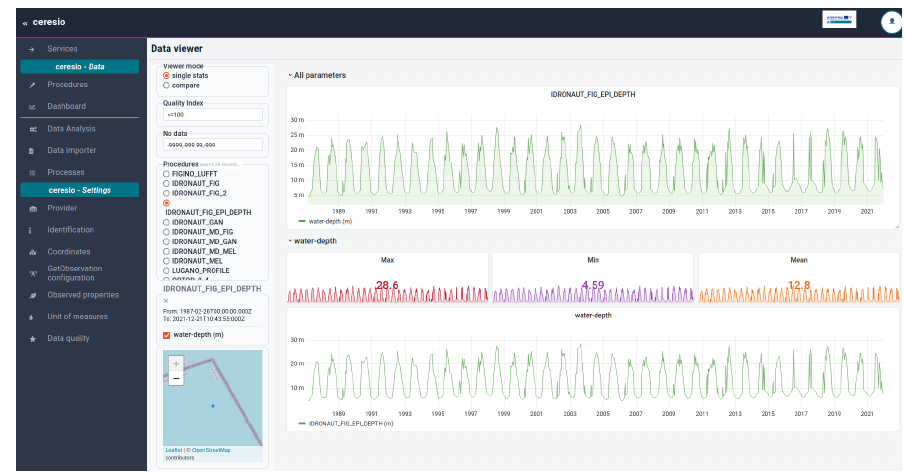
Figure 8. Epilimnion depth calculated using the LakeAnalyer web plugin and the monthly data collected by the traditional campaigns, previously standardized and imported into